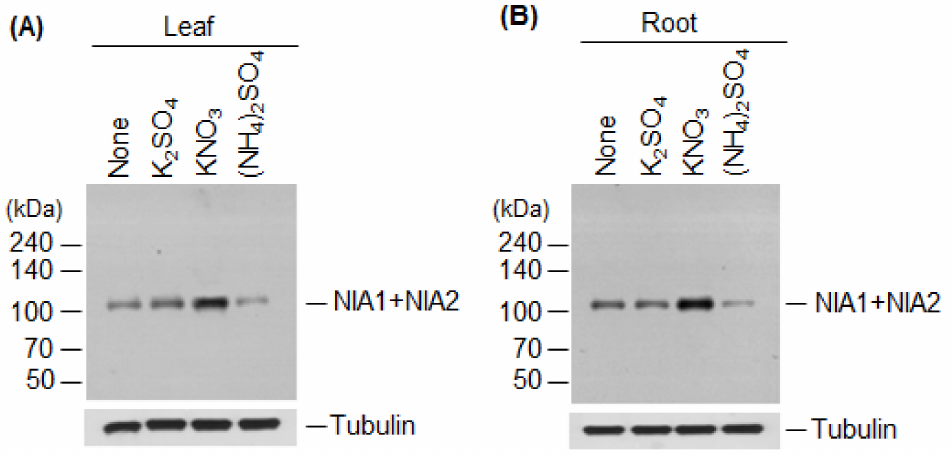
Figure 4. Effect of nitrate or ammonium ion on nitrate reductase levels. The effect of nitrate or ammonium sources on NIA1 and NIA2 protein levels was examined. Wild-type plants were treated with 5 mM K 2 SO 4 , KNO 3 , or (NH 4 ) 2 SO 4 , and total proteins extracted from leaves ( A ) or roots ( B ). NR protein (NIA1 + NIA2) levels were examined by immunoblotting with an anti-NR antibody. Tubulin was used as a loading